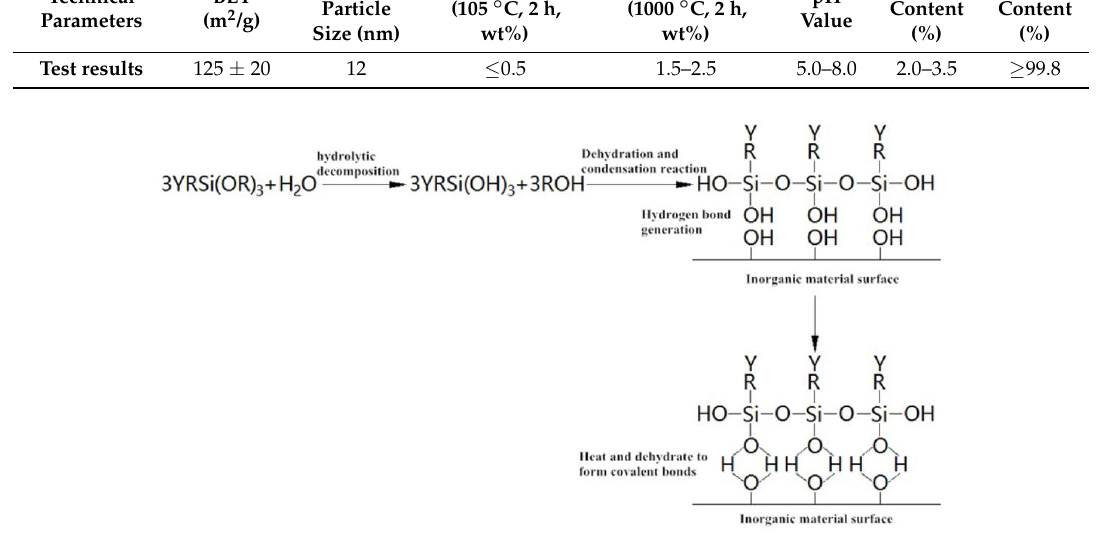
Figure 1. Grafting process of silane coupling agent on nanosilica.